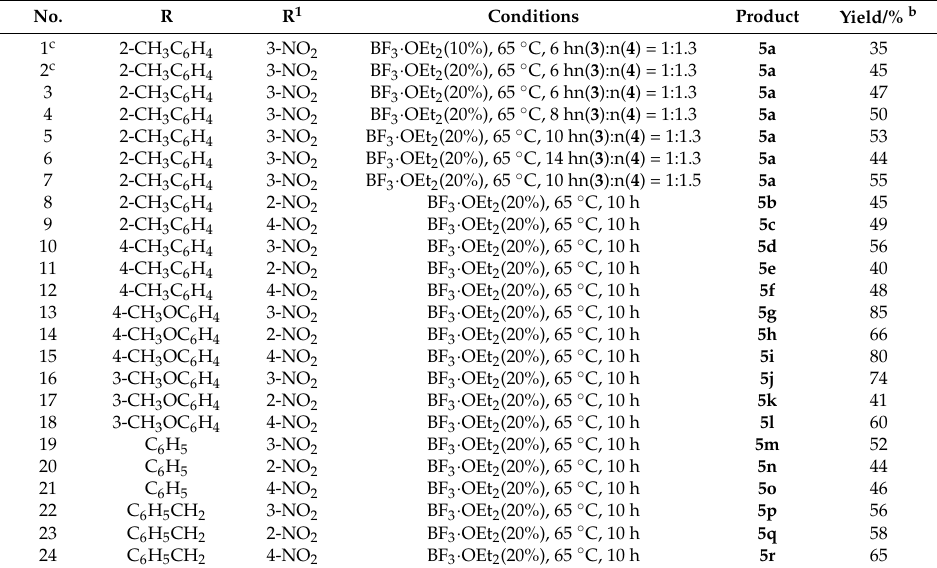
a Unless mentioned in the table, the reaction conditions were: the mole ratio of n ( 3 ):n ( 4 ) = 1:1.5; BF 3 ·OEt 2 : 20 mol % based on compound 3 ; Solvent: THF; Molecular sieve 4Å added; Reaction time: 10 h; Temperature: 65 °C. b Isolated yield. c Without molecular sieve 4Å.